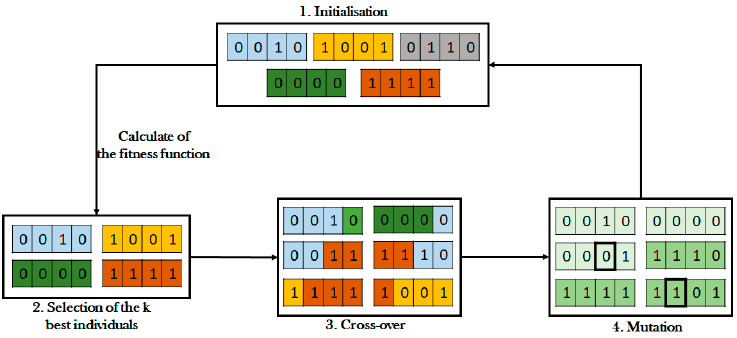
Figure 4. Presentation of the Genetic Algorithm model.